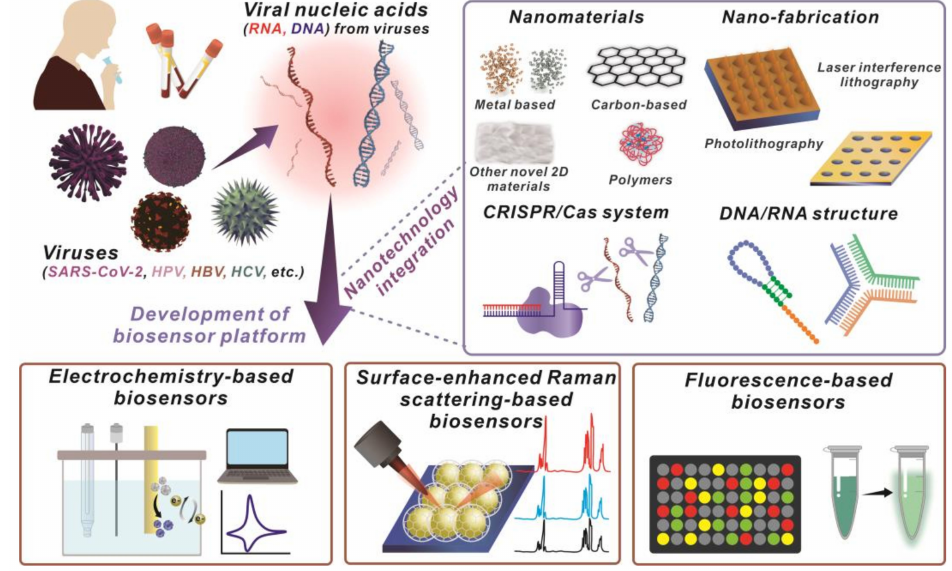
Figure 1. Schematic diagram of nanotechnology-assisted biosensors for the detection of viral nucleic